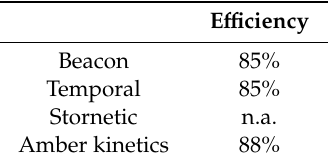
Table 6. E ffi ciency of some commercially available flywheels